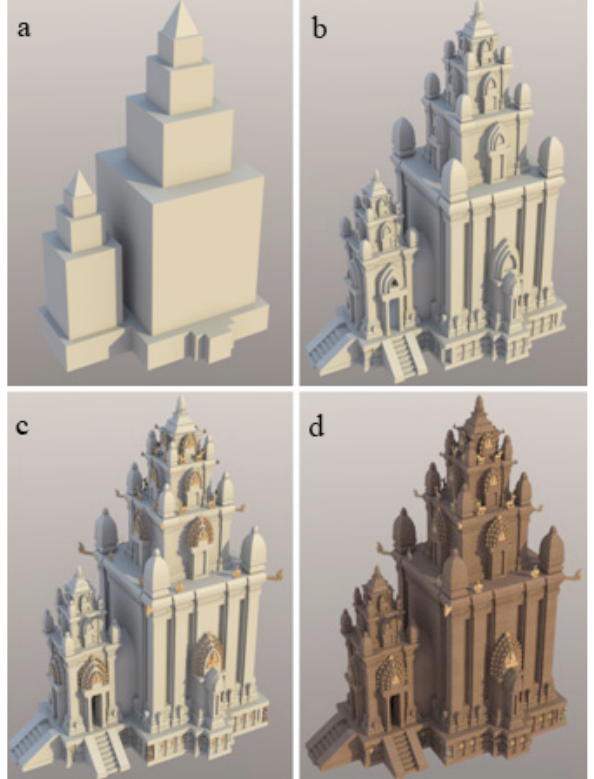
Figure 4. Reconstructive sequence: a) volumetric model; b) architectural structure; c) architecture with decorations; d) final